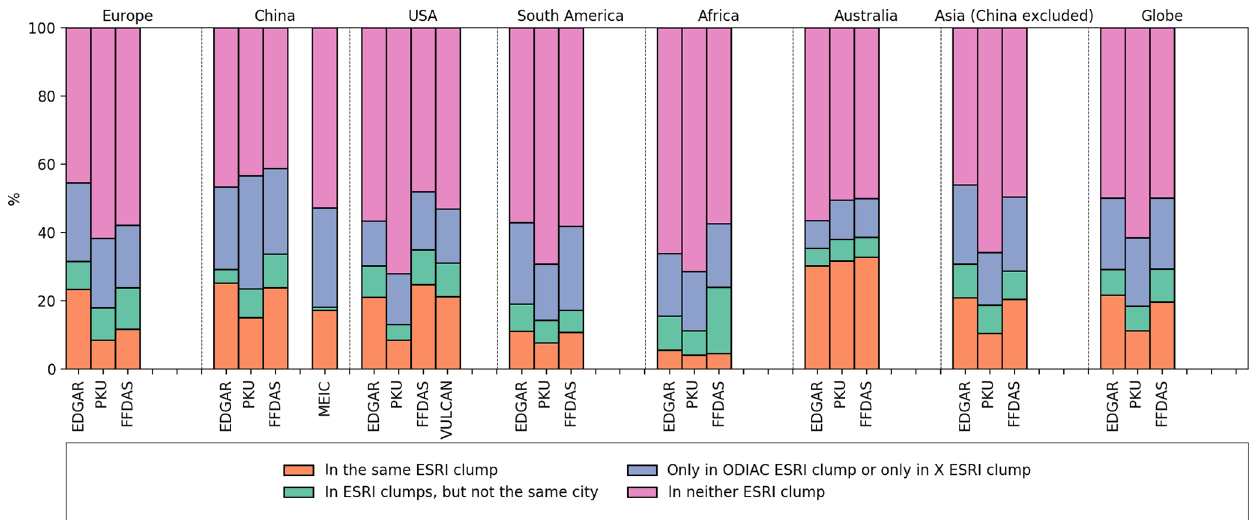
Figure 9. The fractions of emissions from corresponding emission products covered (1) by the same ESRI clump from ODIAC and X (red), (2) by ESRI clumps in both ODIAC and X but do not belong to the same ESRI urban area (green), (3) only by one of the ESRI clump in either ODIAC or X (blue), and (4) by no ESRI clump in ODIAC or in X